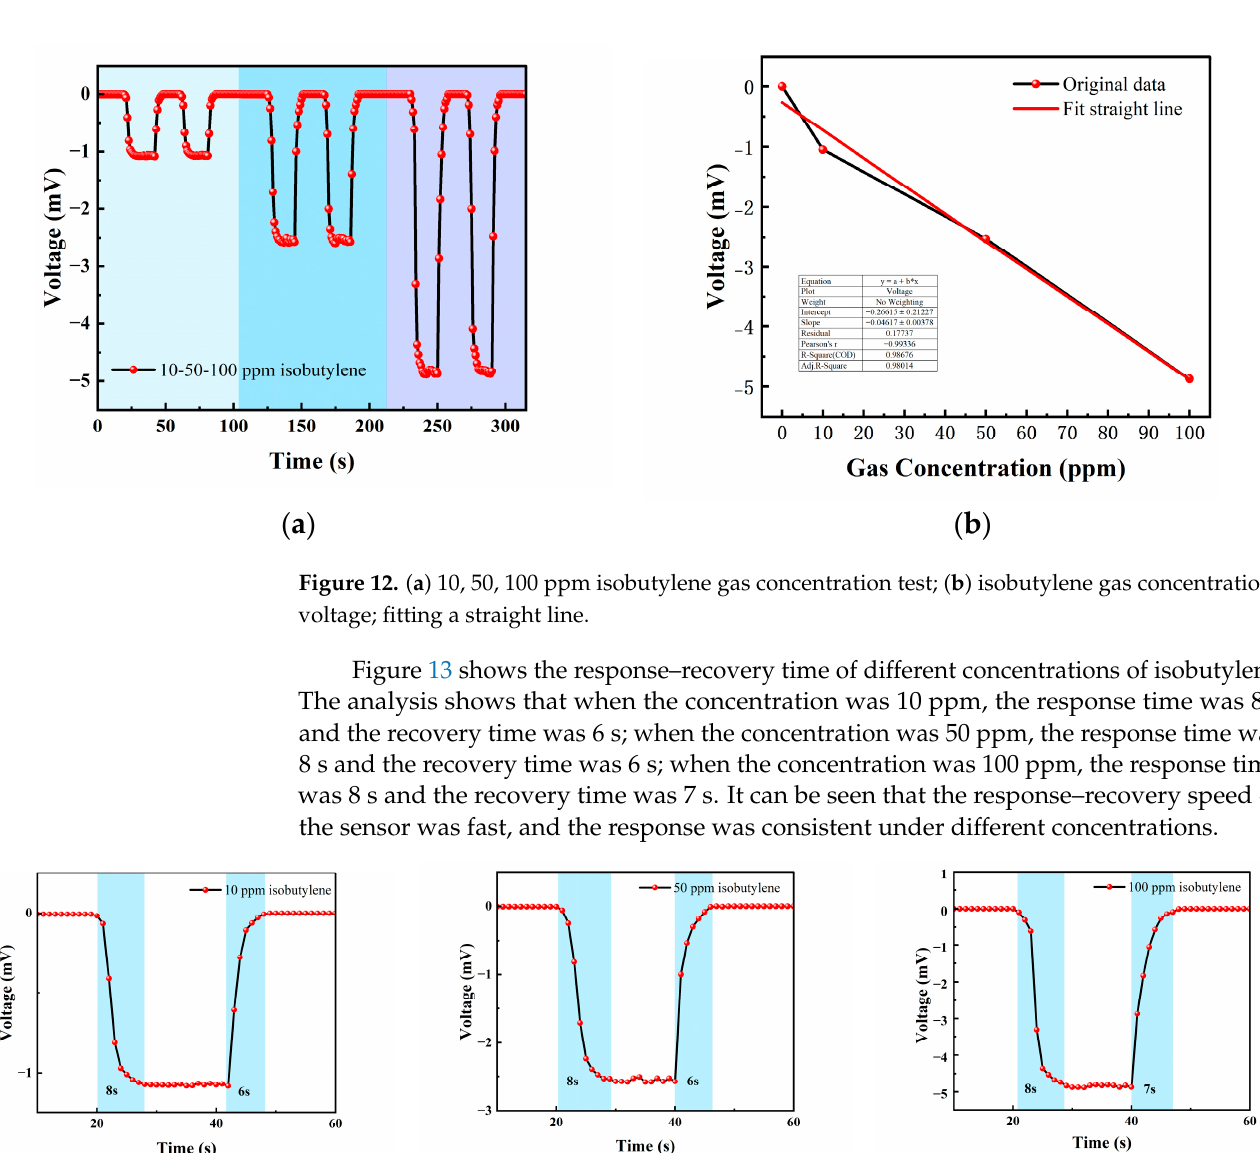
Figure 11. Different isobutylene gas concentration test: ( a ) A 10 ppm isobutylene-Ar cycle test; ( b ) a